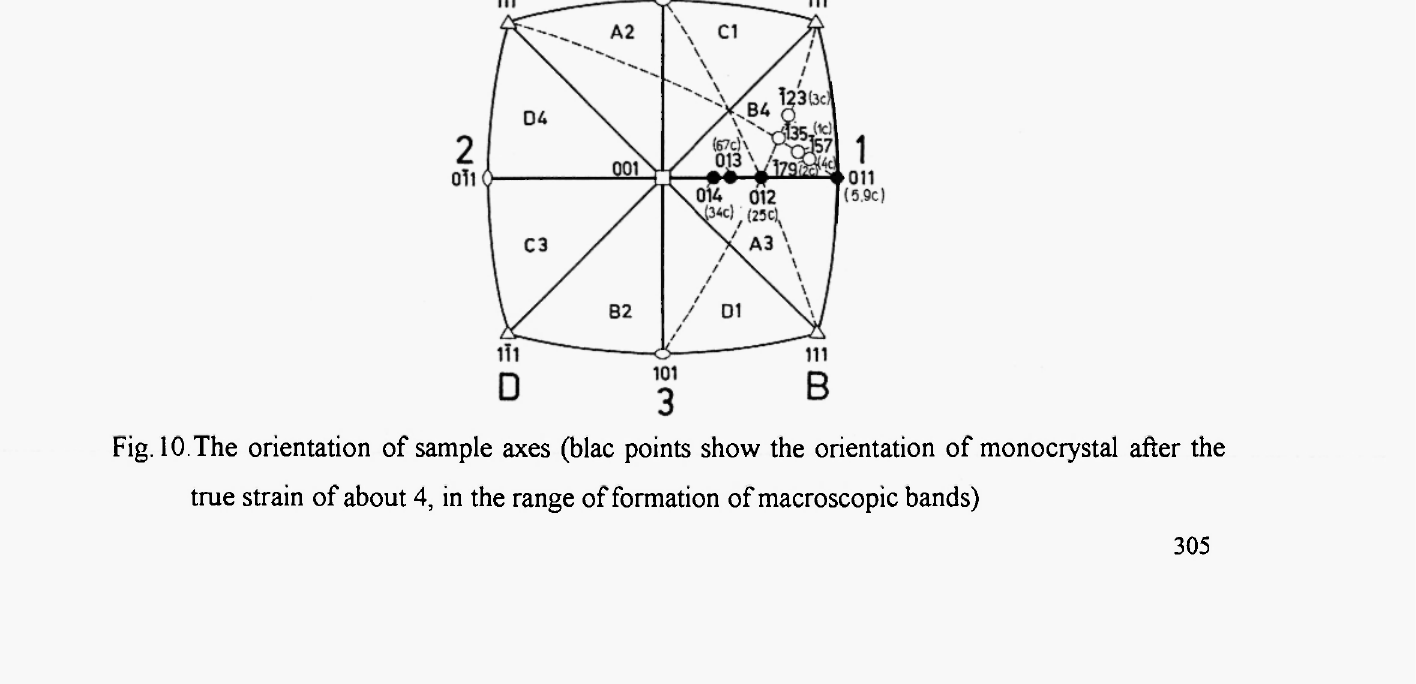
Fig. 10.The orientation of sample axes (blac points show the orientation of monocrystal after the true strain of about 4, in the range of formation of macroscopic